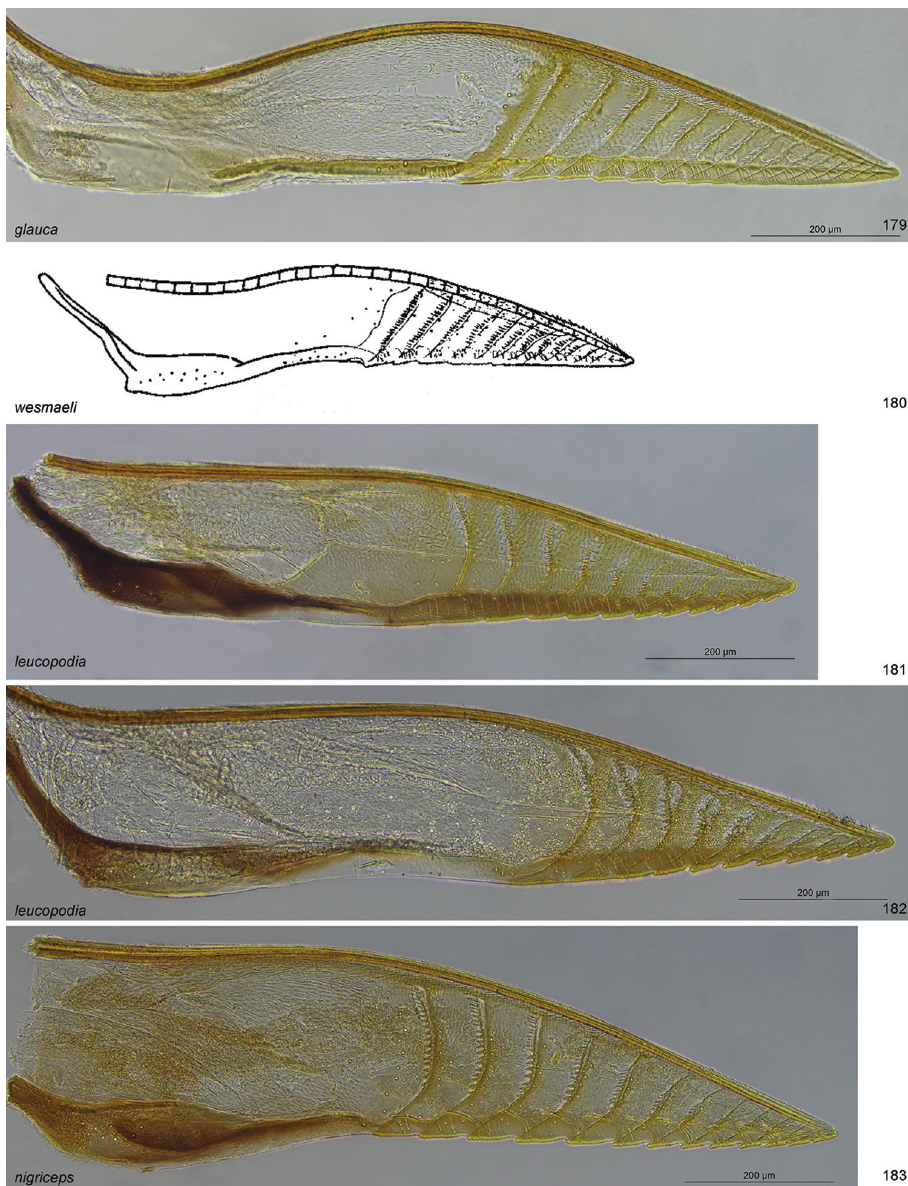
Figures 179–183. Lancets of Pristiphora . 179 glauca DEI-GISHym31573 180 wesmaeli from Wong (1975) 181 leucopodia DEI-GISHym31262 182 leucopodia DEI-GISHym20920 183 nigriceps DEI-